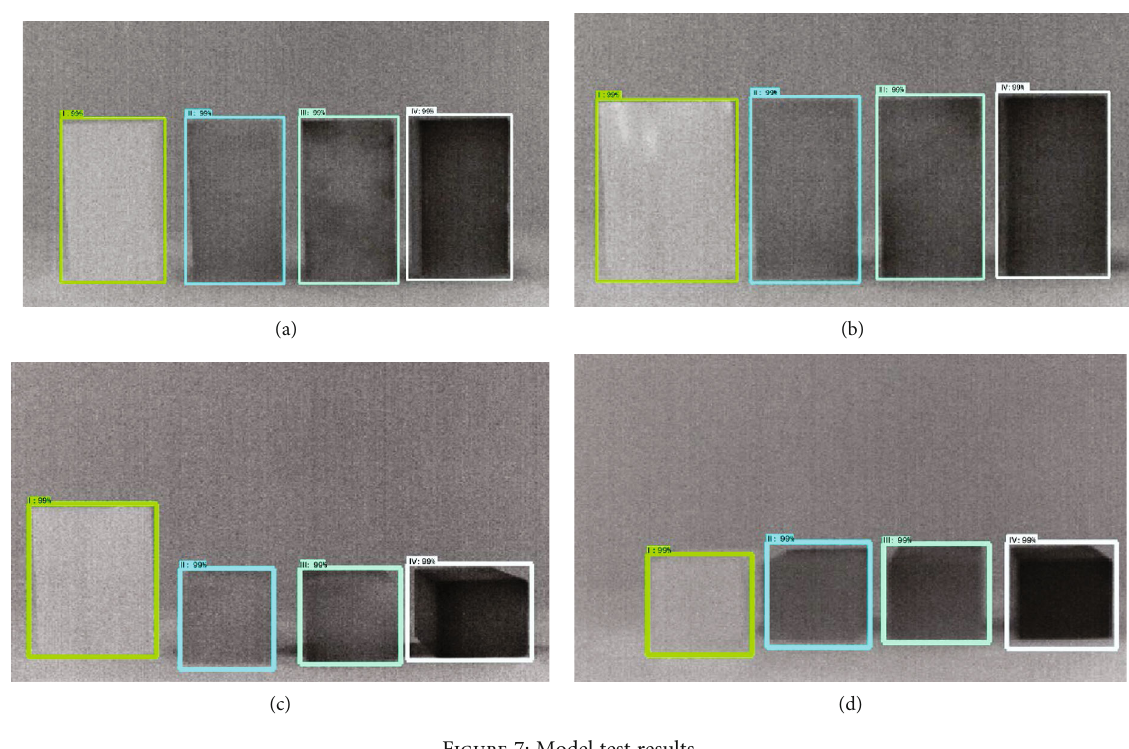
Figure 7: Model test